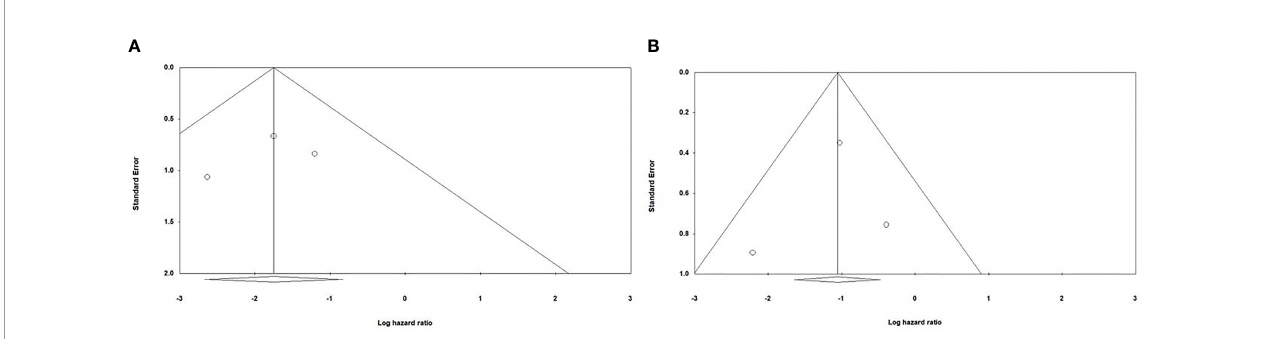
FIGURE 5 | Evaluating potential publication bias among the included studies (A) Evaluating publication bias among the studies investigating the effect of anti-PD-1 administration on the survival of animal models treated with second-generation CAR-T cells; Begg and Mazumdar ’ test one-tail P-value=0.30075 and two-tail P-value = 0.60151; Egger ’ s test one-tail P-value=0.3272 two-tail P-value=0.65456 (B) Evaluating publication bias among the studies investigating the effect of PD-1 knockdown on the survival of animal models treated with CAR-T cells; Begg and Mazumdar ’ test one-tail P-value=0.30075 and two-tail P-value =0.60151; Egger ’ s test one-tail